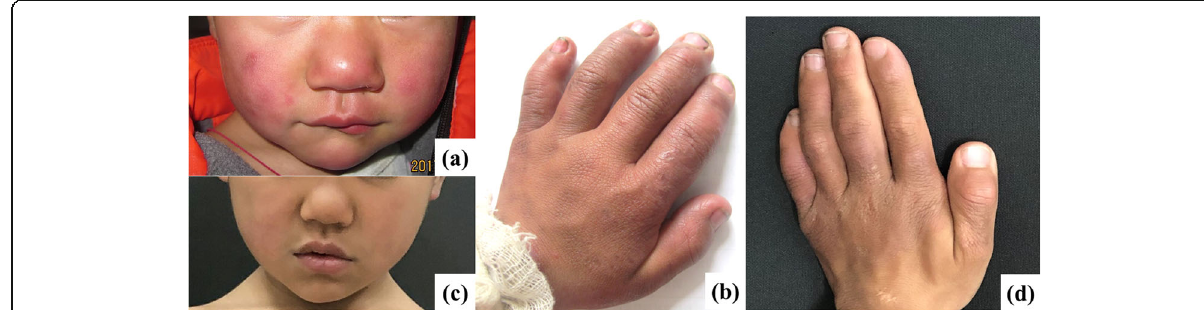
Fig. 1 Clinical findings at first visit and after treatment. Multiple erythematous plaques on his face, hands and feet, long clubbed fingers before treatment a, b . Significant improvement after therapy c, d